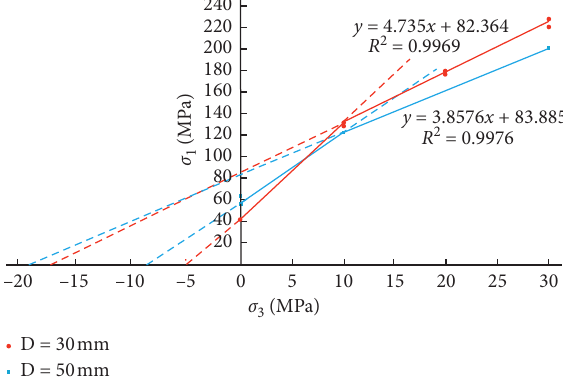
Figure 3: Strength curves of sandstone samples.